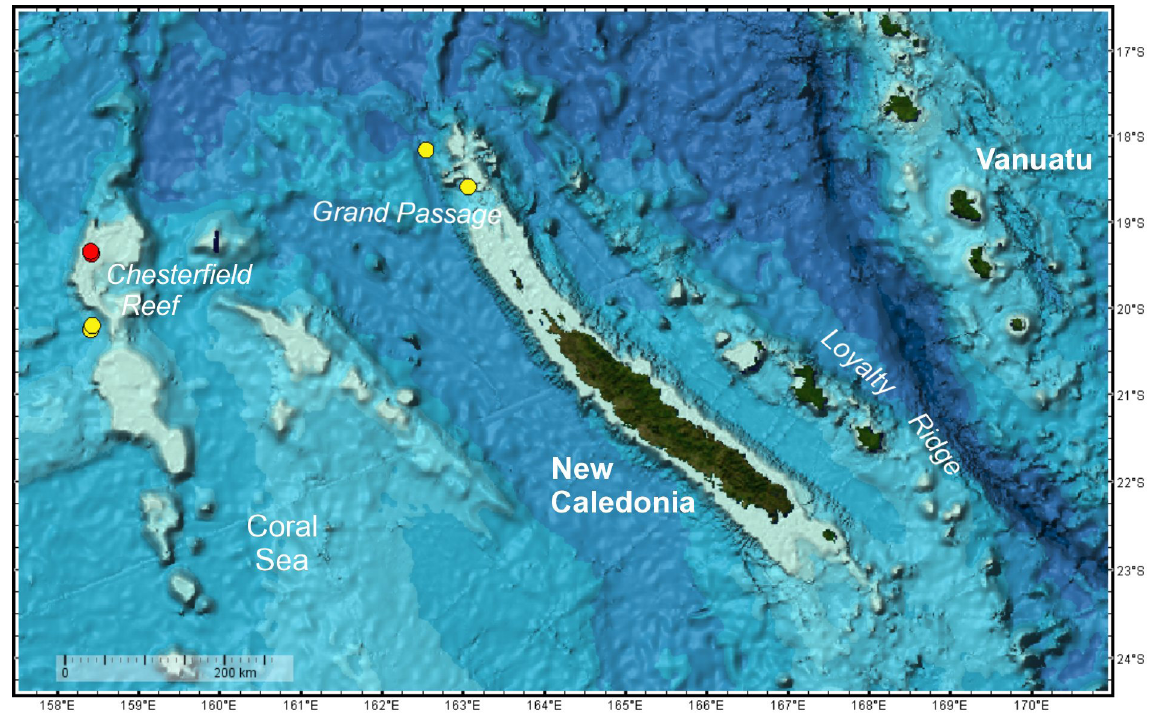
Fig. 10. Distribution map for Profundiconus virginiae sp. nov. (red circles) and P. barazeri sp. nov. (yellow circles). Symbols indicate the points where each of the species have been